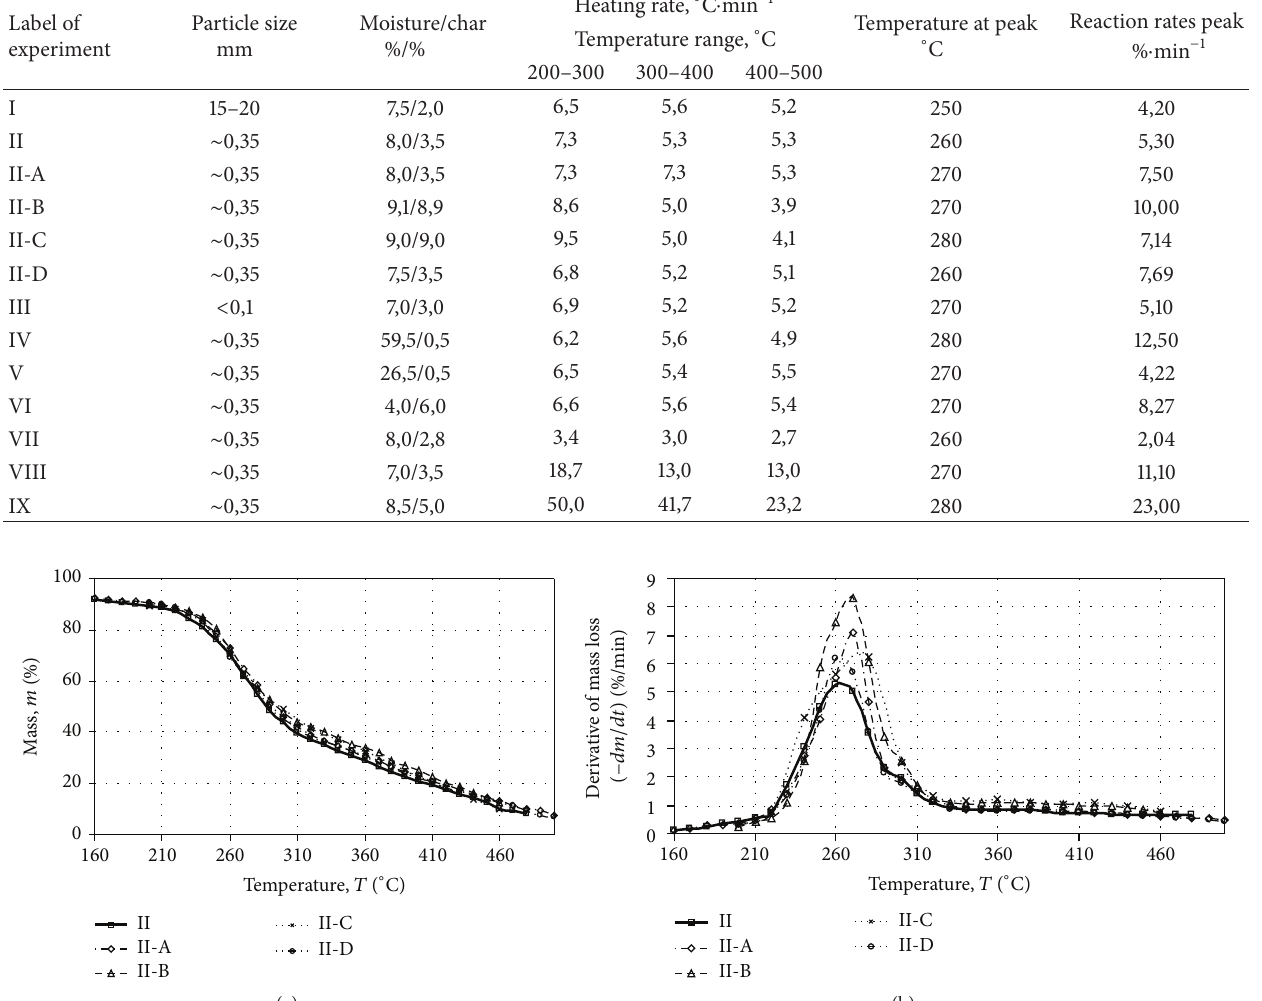
Figure 2: (a) TGA profile of wheat straw at experiments II; (b) DTG curves of experiments